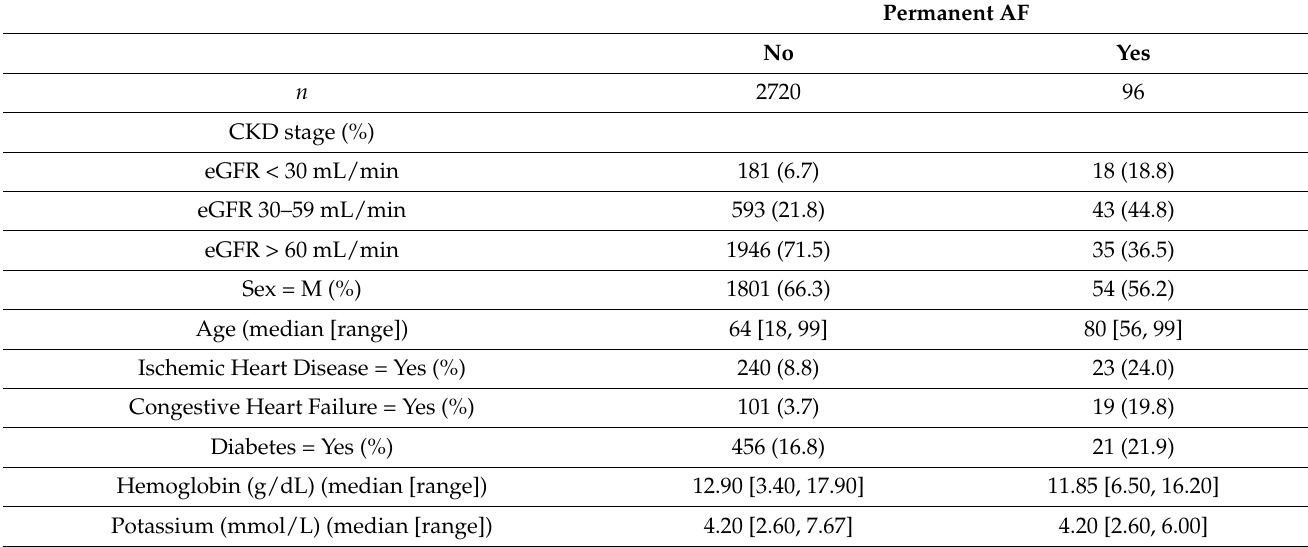
Table A3. Differences between patients with permanent AF and the rest of the population.